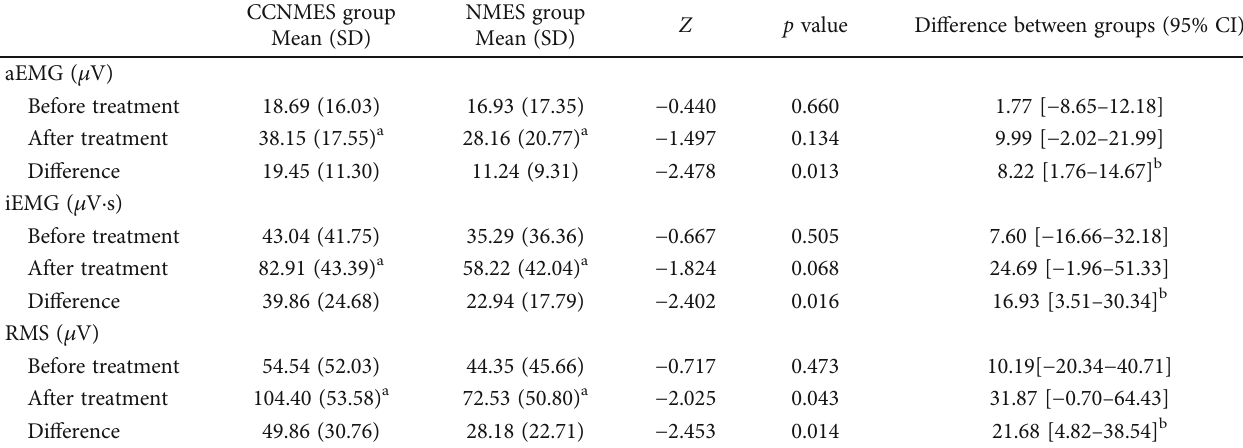
Table 3: Comparison of sEMG - related indices between the two groups and between before and after